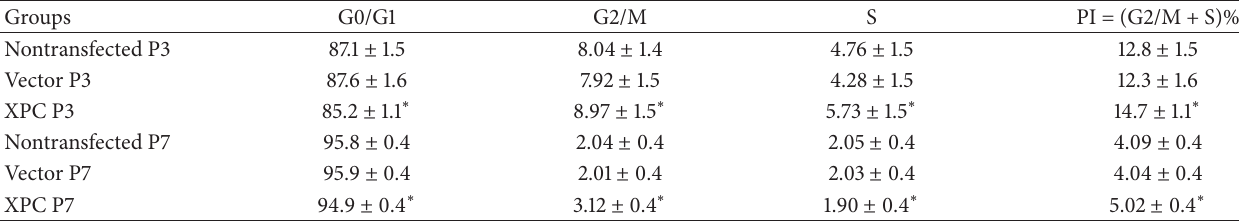
Table 3: Cell cycle of DPCs with long-term in vitro culture after XPC